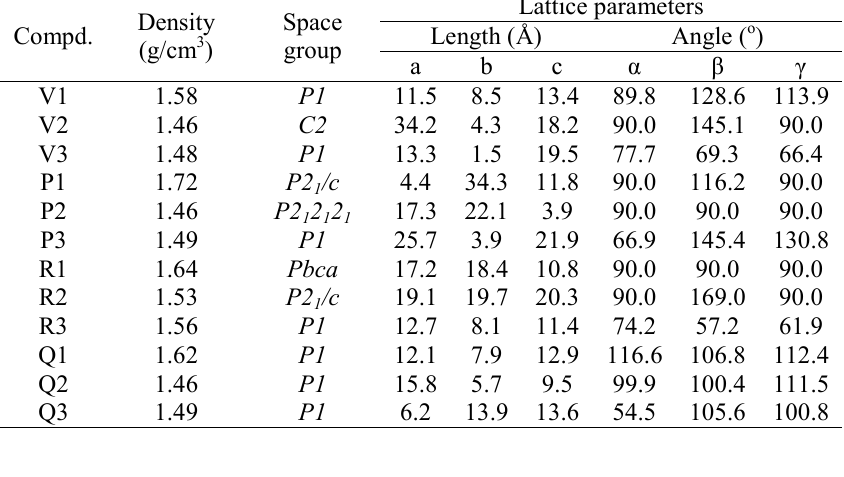
Table 3. The calculated densities and lattice parameters of the triazine derivatives. Compd.